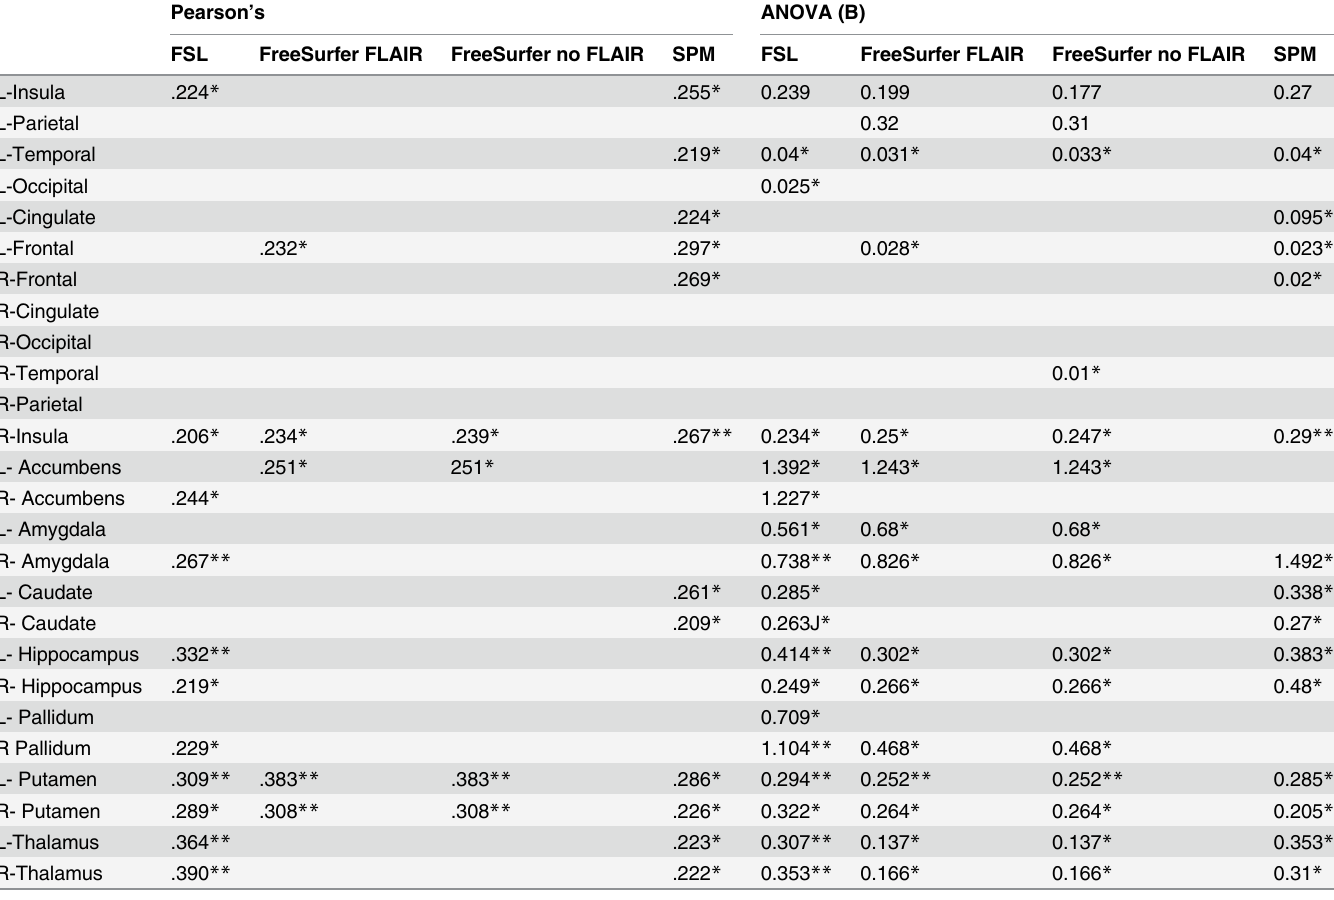
Table 5. Statistically significant correlations lobar GM volumes with cognitive